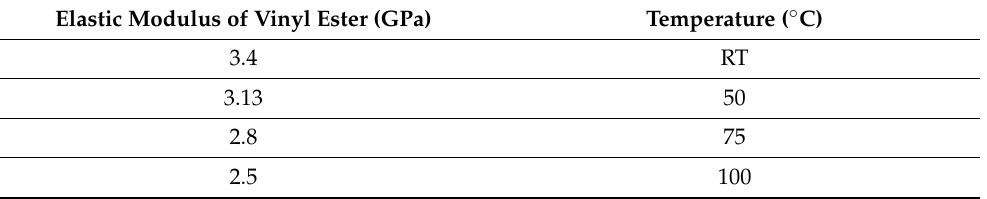
Table 6. Modules of Elastollan R3000 at wide range of temperatures are extracted from Figure 5 in Ref. [32].